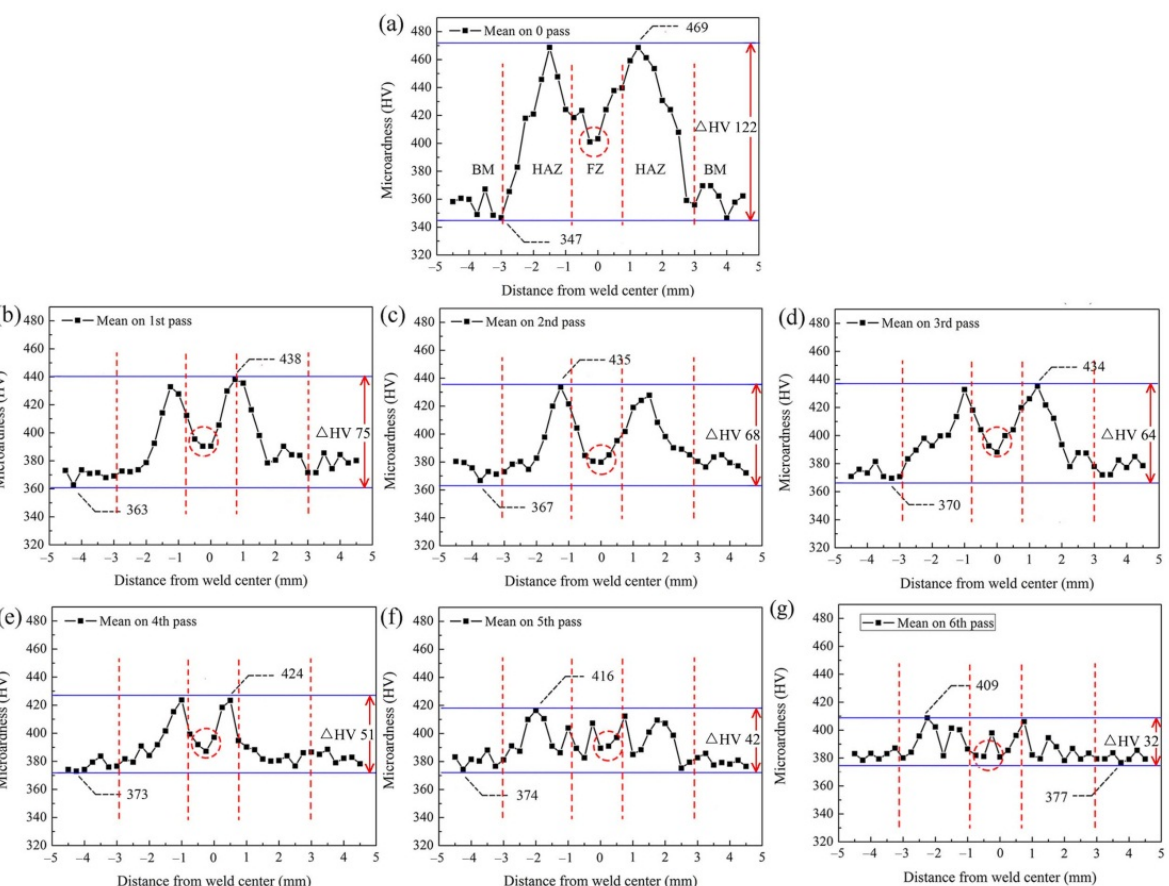
Figure 15. Microhardness evolution of the weld joint during 6-pass hot power spinning: ( a ) initial welded tube, ( b ) pass 1st, ( c ) pass 2nd, ( d ) pass 3rd, ( e ) pass 4th, ( f ) pass 5th, ( g ) pass 6th. The tensile strength of the spun workpieces of base metal in axial direction and tangential direction were listed in Table 4. After six-pass spinning, the UTS (ultimate tensile strength) in axial/tangential direction was increased to 1245/1299 MPa from 1206/1010 MPa of the as-received rolled sheet, respectively, mainly due to the effect of fine grain strengthening. Besides, another factor should not be ignored, i.e., the reduction in B2 phase content from 55.4% of as-received sheet to 44.1% of spun tube in final pass, as well as the increase in O phase content from 31.4% to 43.8% correspondingly. Shao et al. reported that the B2 phase deformation ability was much better than that of O and α 2 phases since the BCC microstructure had more slip systems [1]. On the other hand, after six-pass spinning, the anisotropy of mechanical properties was reversed, the highest UTS changed from the axial direction to the tangential direction, which should be attributed to the co-effect of texture transformation and O phase morphology evolution caused by multiple-pass